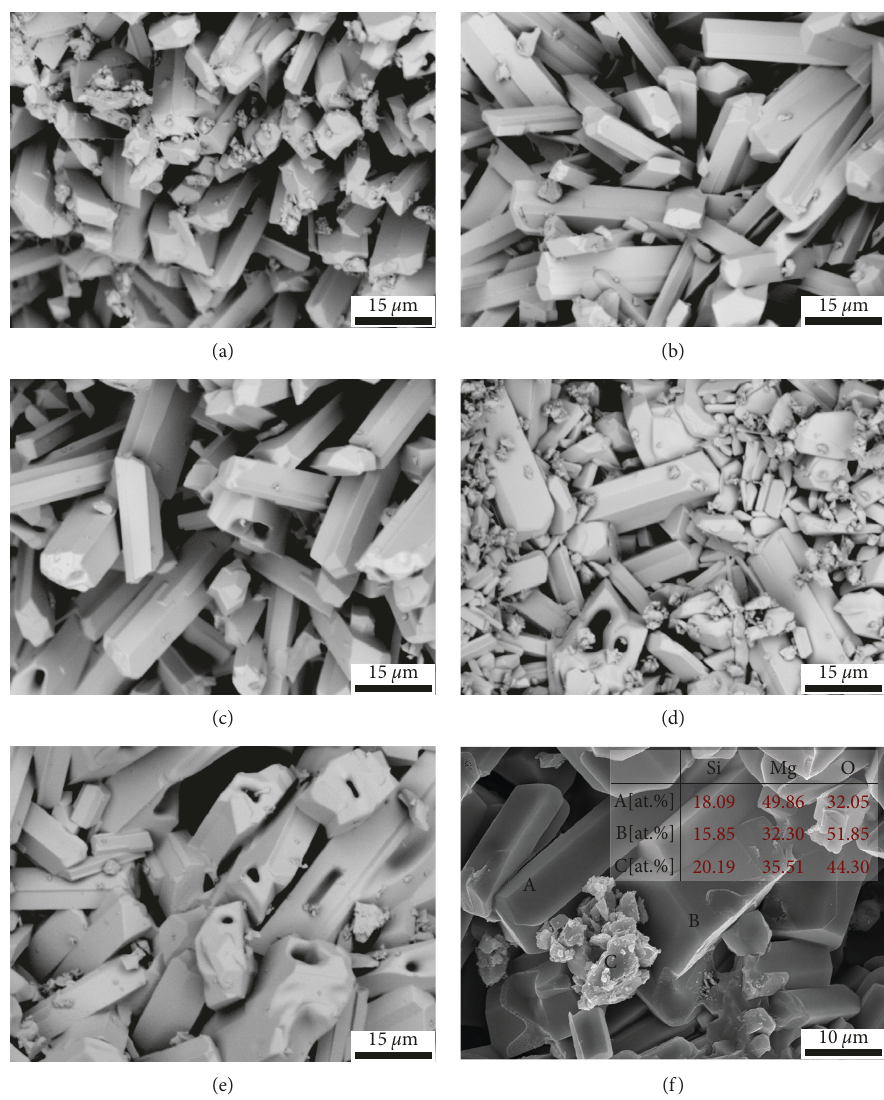
Figure 3: SEM images of (Mg 0.95 Cu 0.05 ) 2 SiO 4 with 12% B 2 O 3 –LiF sintered at (a) 1000 (f) EDS pattern of microdomain marked in Figure